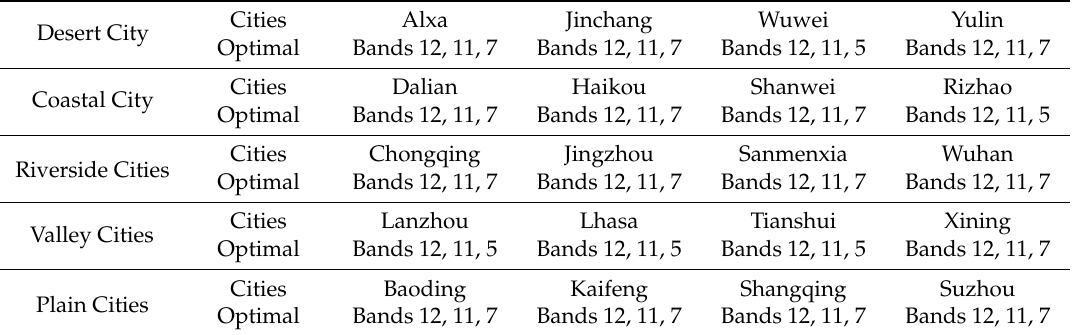
Table 3. Optimal band combination.